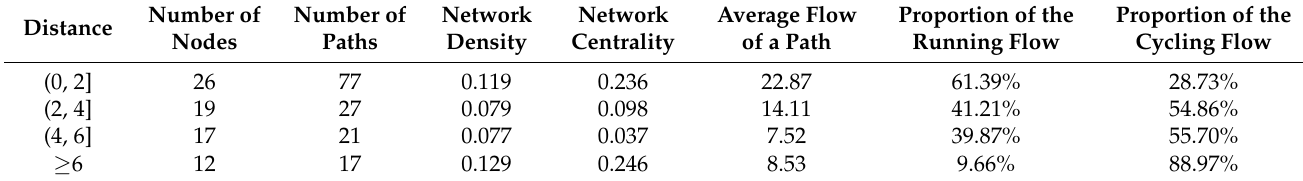
Table 4. Network characteristics under different distances.